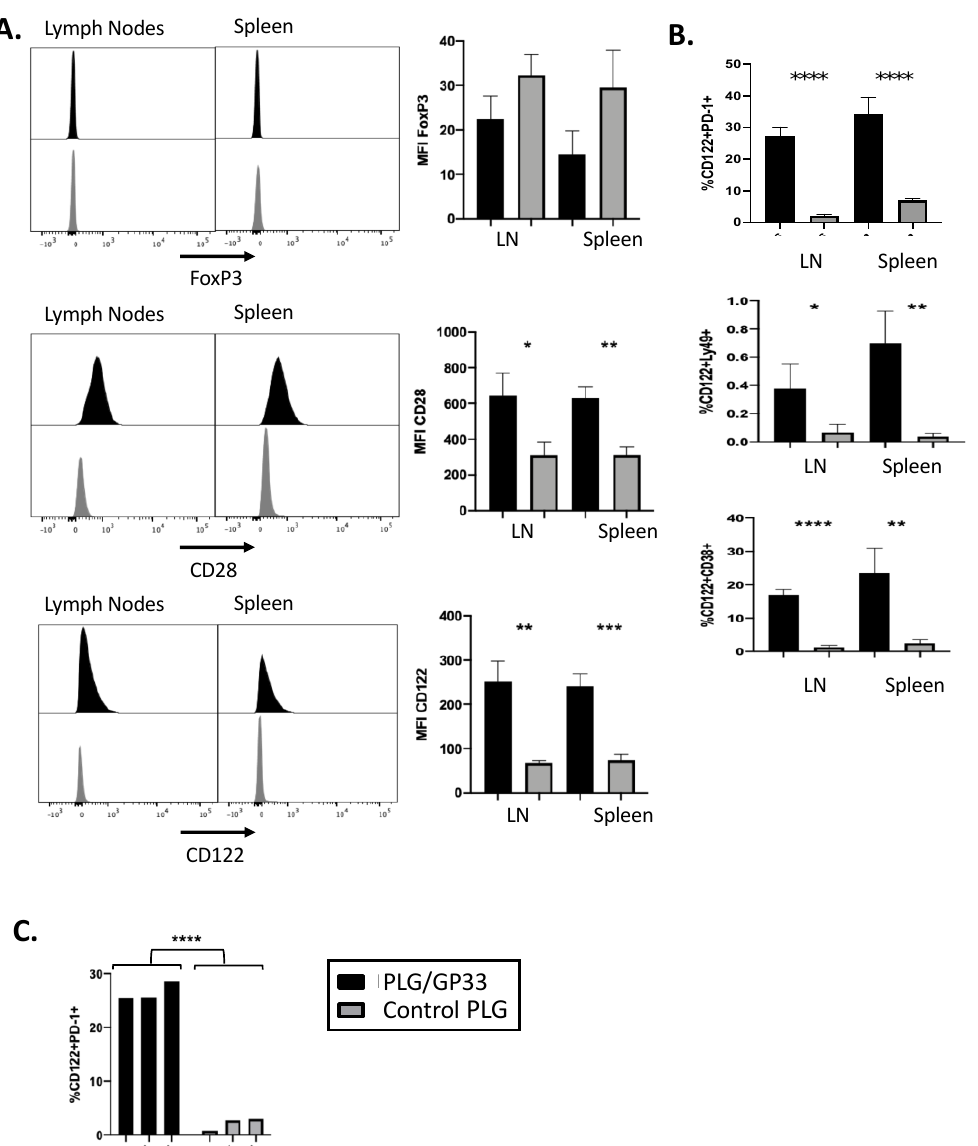
Figure 2. Antigen-encapsulating PLG/GP33 nanoparticles expand CD8 + Tregs in transgenic P14 mice. 3–4 female P14 mice were injected intravenously with either PLG/GP33 or a control PLG (PLG/OVA323 or PLG). Spleens and/or lymph nodes (pooled axillary, brachial, and inguinal) were harvested and counted 3 days later. Viable T cells were analyzed by flow cytometry. Statistical significance was determined by Student’s t -test. * p < 0.05, ** p < 0.01, *** p < 0.001, **** p < 0.0001. ( A ) Expression of FoxP3, CD28, or CD122 was determined by geometric mean fluorescence intensity (MFI). ( B ) Sub-populations were determined by percentage of viable CD8 + cells that were double positive for CD122 and PD-1, Ly49, or CD38. ( C ) Female P14 mice ( n = 3) at various ages (young 4 weeks of age, adult 8 WOA, old 12 WOA) were injected intravenously with either PLG/GP33 or PLG/OVA323. Expansion of Tregs was determined by percentage of all viable CD8 + T cells that were double positive for CD122 and PD-1 by flow cytometry. Statistical significance between the groups was determined by considering three ages as three replicates.